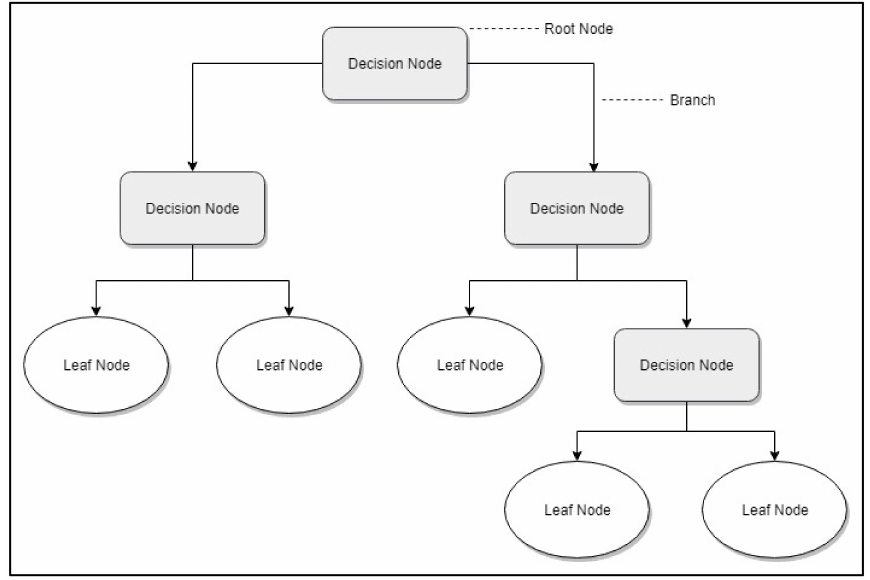
Figure 1. Topology of decision